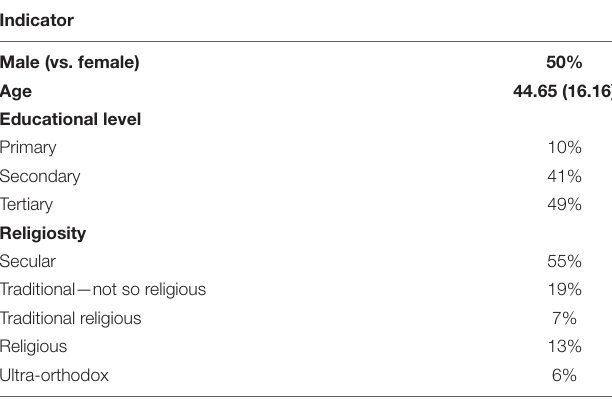
TABLE 1 | Demographic composition of the sample in terms of gender, age, educational level and religiosity.